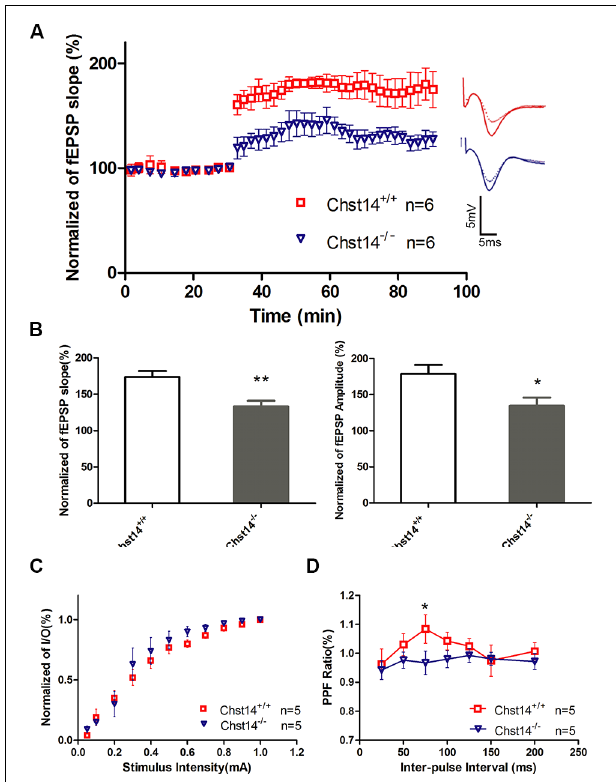
FIGURE 2 | Chst14/D4st1 deficiency reduces long-term potentiation (LTP) formation in hippocampal slices. Hippocampal slices from WT or Chst14 − / − mice at 3 months of age ( n = 6 mice for each group) were freshly prepared and subjected to LTP induction and analysis. (A) Time course of the effects of high-frequency stimulation (HFS) on the field excitatory postsynaptic potential (fEPSP) initial slope. (B) Cumulative data showing the mean fEPSP peak amplitude and the mean fEPSP slope 60 min post-HFS. (C) Input-output (I/O) plots of fEPSP slopes vs. current input (mA) were similar in WT and Chst14 − / − mice (five slices from four mice), indicating that lack of dermatan sulfate (DS) does not alter baseline synaptic transmission. (D) Paired pulse facilitation (PPF) analysis showing the S2/S1 ratios for increasing stimulation interpulse intervals in slices from WT and Chst14 − / − mice (five slices from four mice). Error bars represent SEM. ∗ p < 0.05, ∗∗ p < 0.01.